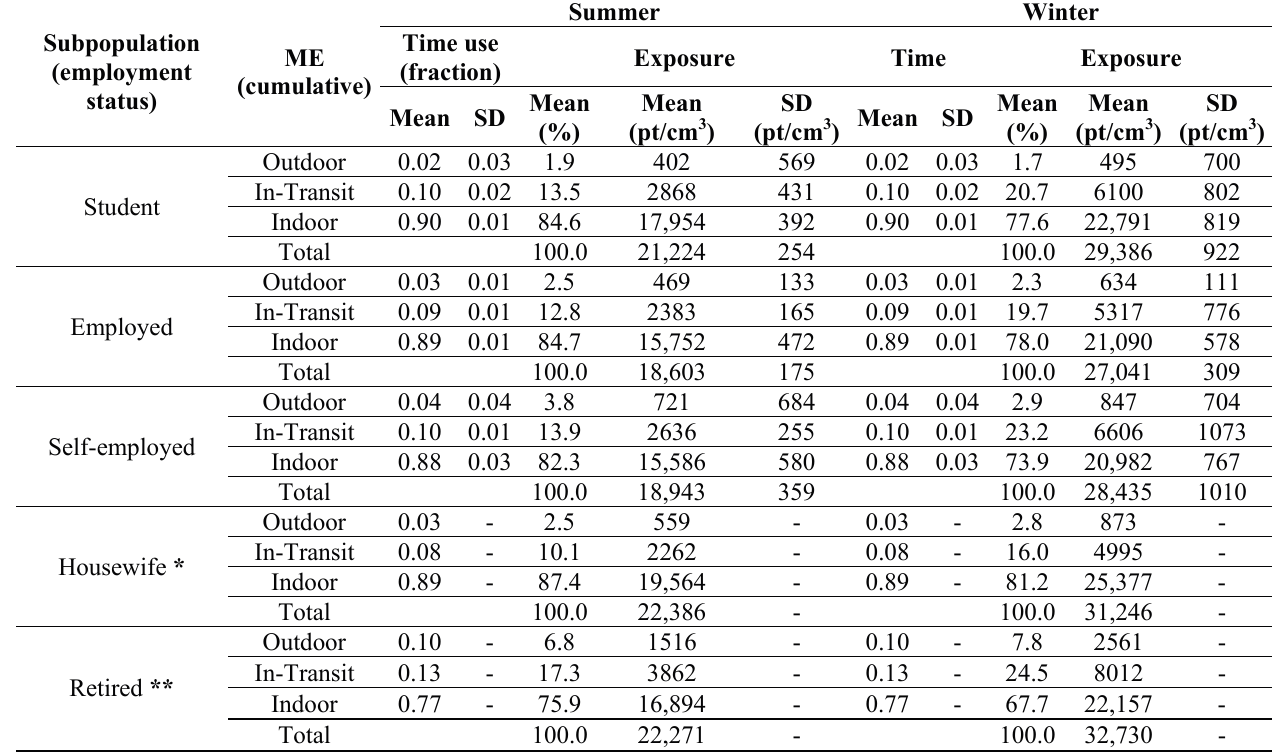
Table 6. Summary of the mean simulated exposures, segregated for cumulative MEs and season. Results are shown for employment-segregated subpopulations within the Milan urban area.